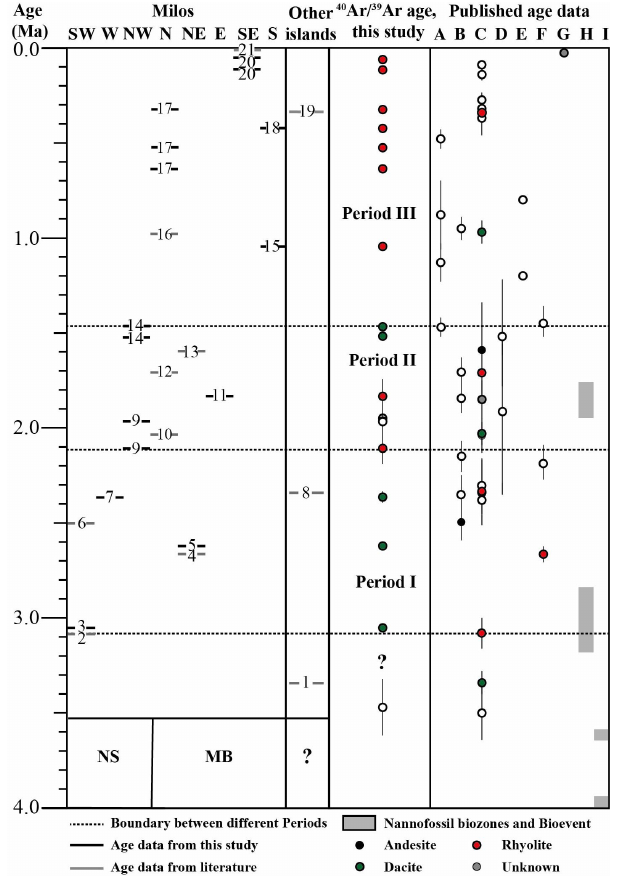
Figure 14. Diagram presenting three periods of different long-term volumetric volcanic output rate of the Milos volcanic field based on the new 40 Ar / 39 Ar data of this study and published data. The location of the different volcanoes is given in Fig. 2 and indicated in the left panel (from left to right: SW, W, NW, N, NE, E, SE and S of Milos). The right panel corresponds to published age data: A – Fytikas et al. (1976); B – Angelier et al. (1977); C – Fytikas et al. (1986); D – Bigazzi and Radi (1981); E – Matsuda et al. (1999); F – Stewart and McPhie (2006); G – Traineau and Dalabakis (1989). Biostratigraphic data of the Neogene sediments (NGs) are from H (Calvo et al., 2012) and I (Van Hinsbergen et al., 2004) calibrated to Raffi et al. (2020) (LCO of Sphenolithus spp. and FO of Dis- coaster tamalis ). The number in the left panel represents the vol- canic centres of Milos (see details in Table 5). The start of volcan- ism (3.08–3.61Ma) on Milos and the basement of the other islands (Antimilos, Kimolos and Polyegos) are not well constrained and in- dicated with question marks (see text for discussion). The simplified basement cross section (NS: Neogene sedimentary rock; MB: Meta- morphic basement) under Milos volcanic units is based on Fytikas et al. (1989). We used the filled symbols as the best estimate for the eruption ages at the different volcanic centres, and the open sym- bols are not used as the best estimate due to their relatively large